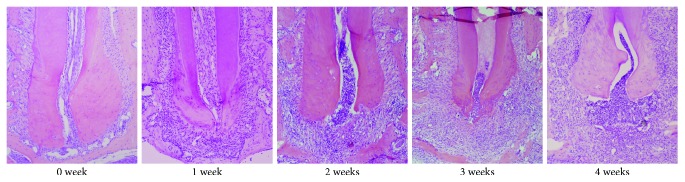
Results of HE staining of periapical tissues in mice at each time point (100x).